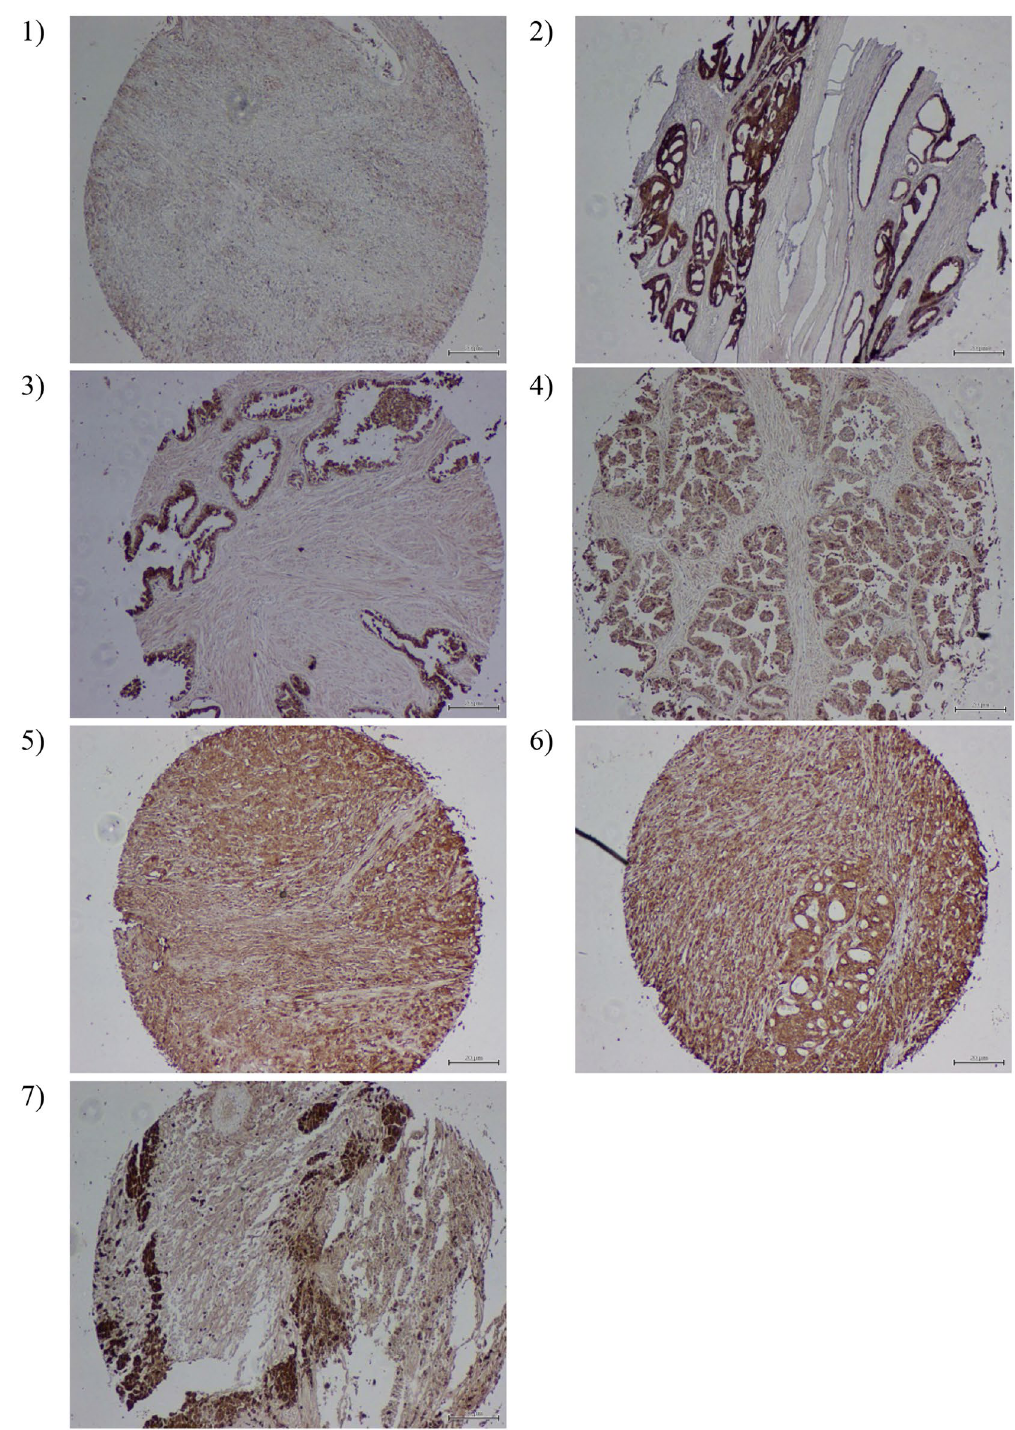
Figure 6 . Immunohistochemistry of tissue microarray to validate TPD52 overexpression in PCa. ( A ) Representative data from immunohistochemical studies of 24 prostate cancer specimens are shown. ( A1 ) TPD52 expression in a normal, healthy, 33-year-old prostate, with low however noticeable staining observed in glandular epithelia. ( A2 ) TPD52 expression in prostate cancer nodules that are heavily stained, benign prostatic hyperplasia in their vicinity was low for TPD52 expression which is comparable with a normal level. ( A3 ) TPD52 in high-grade PIN with adjacent normal glands. Epithelia of the high-grade PIN exhibited a general up-regulation of TPD52; adjacent normal or unaffected epithelial cells displayed low-level staining. ( A4 ) Uniformly high expression of TPD52 in PCa cells of Gleason scores 3 tumors. ( A5-6 ) Representative specimens showed prevalently high TPD52 expression in PCa of type Gleason score 4 tumors. ( A7 ) TPD52 staining shown in malignant melanoma section (tissue marker), with high expression of TPD52 in malignant cells of melanoma surrounded by neighboring normal unaffected cells representing low staining of